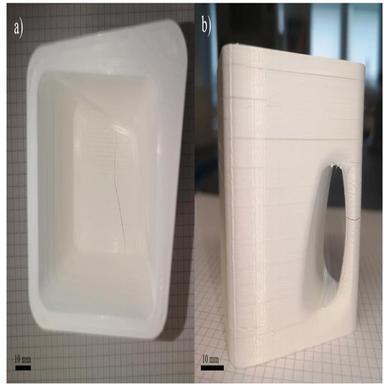
Cup printed using SiCeram filament showing a) cracks at the bottom, and b) inter-layer cracks after solvent debinding.